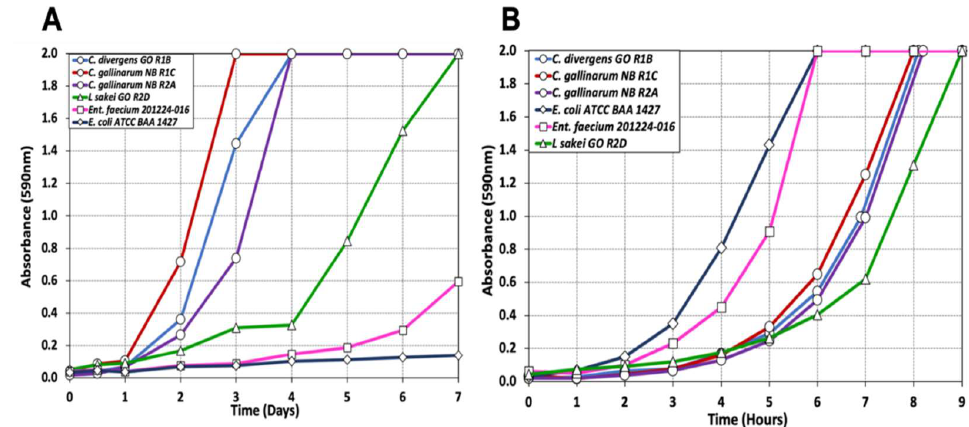
Figure 2. Spectrophotometric growth assay of bacteria isolated from marinated and dried biltong beef ( C. divergens GO R1B; C. gallinarum NB R1C; C. gallinarum NB R2A; L. sakei GO R2D) compared to known mesophilic bacteria ( E. faecium 201224-016; E. coli BAA ATCC 1427) at incubation temperatures ( A ) 5 ◦ C and ( B ) 30 ◦ C. Absorbance (at 590 nm) of each culture was measured every hour at 30 ◦ C and every 24 h at 5 ◦